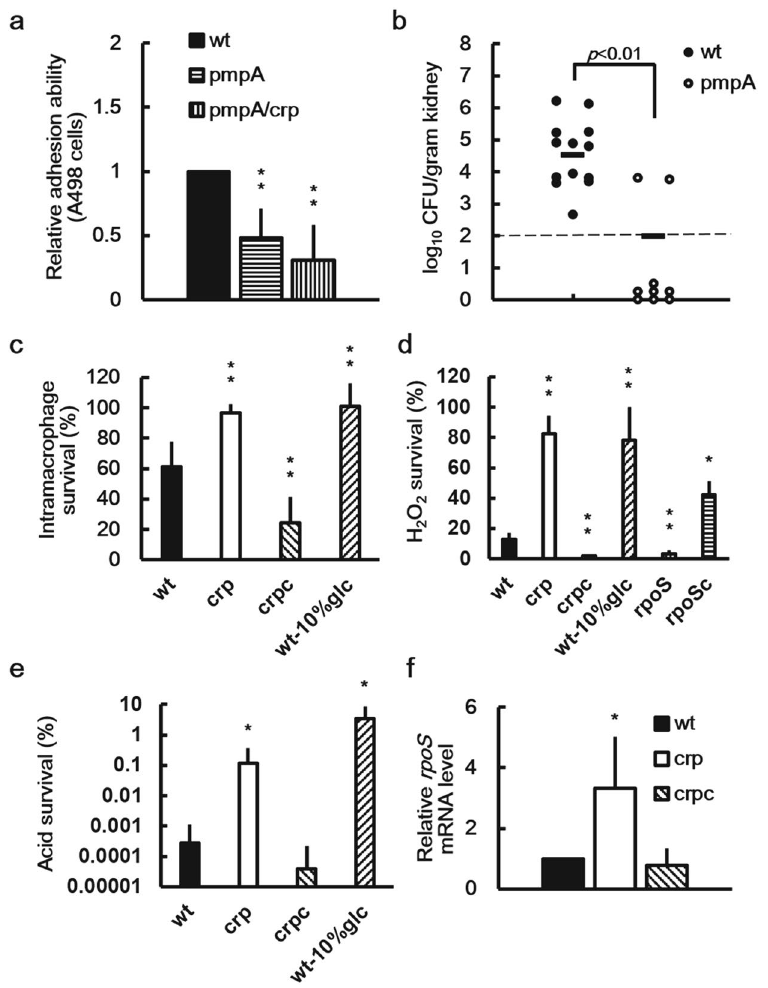
Figure 5. Loss of pmpA abolished the increased kidney adhesion of crp mutant and decreased kidney colonization, and crp mutant displayed enhanced stress tolerance and upregulation of RpoS. ( a ) Adhesion of wild-type P . mirabilis , pmpA mutant or pmpA / crp double mutant to A498 cells. Adhesion abilities were determined as in Fig. 2. ( b ) Mouse kidney colonization by the wild-type or pmpA mutant. Colonization was determined as in Fig. 2b. ( c ) Intramacrophage survival of the wild-type in the absence or presence of 10% glucose, crp mutant and crp -complemented strain. THP-1 cells were infected with bacteria for 30 min at an MOI of 10. Intramacrophage survival was determined as the percentage of viable bacteria that survived in the macrophages for 4 h versus those for 1 h after outside bacteria were killed with streptomycin. ( d ) Survival in H 2 O 2 of wild-type in the absence or presence of 10% glucose, crp mutant, crp -complemented strain, rpoS mutant and rpoS -complemented strain. Overnight cultures were regrown and adjusted to a density of 10 8 cells/ ml before cells were exposed to 30 mM H 2 O 2 for 20 min at 37 °C. The percent cell survival was determined by colony counting relative to the untreated control. ( e ) Survival in acid of wild-type in the absence or presence of 10% glucose, crp mutant and crp -complemented strain. Overnight bacterial cultures were regrown before cells were challenged with acid (pH 3.0) for 2 h. The percent cell survival was obtained as in ( d ). ( f ) Loss of crp increased the rpoS mRNA level. The mRNA amounts in the wild-type, crp mutant and crp -complemented strain were quantified sing real-time RT-PCR at 3 h after incubation. The value obtained for the wild-type was set at 1. In ( a , c – f ), the data represent the averages and standard deviations of three independent experiments. The significant difference from the wild-type was determined by Student’s t test ( * P < 0.05; ** P < 0.01). wt, wild- type; pmpA, pmpA mutant; crp, crp mutant; pmpA/crp, pmpA / crp double mutant; crpc, crp -complemented strain; wt-10%glc, wild-type with 10% glucose; rpoS, rpoS mutant; rpoSc, rpoS -complemented